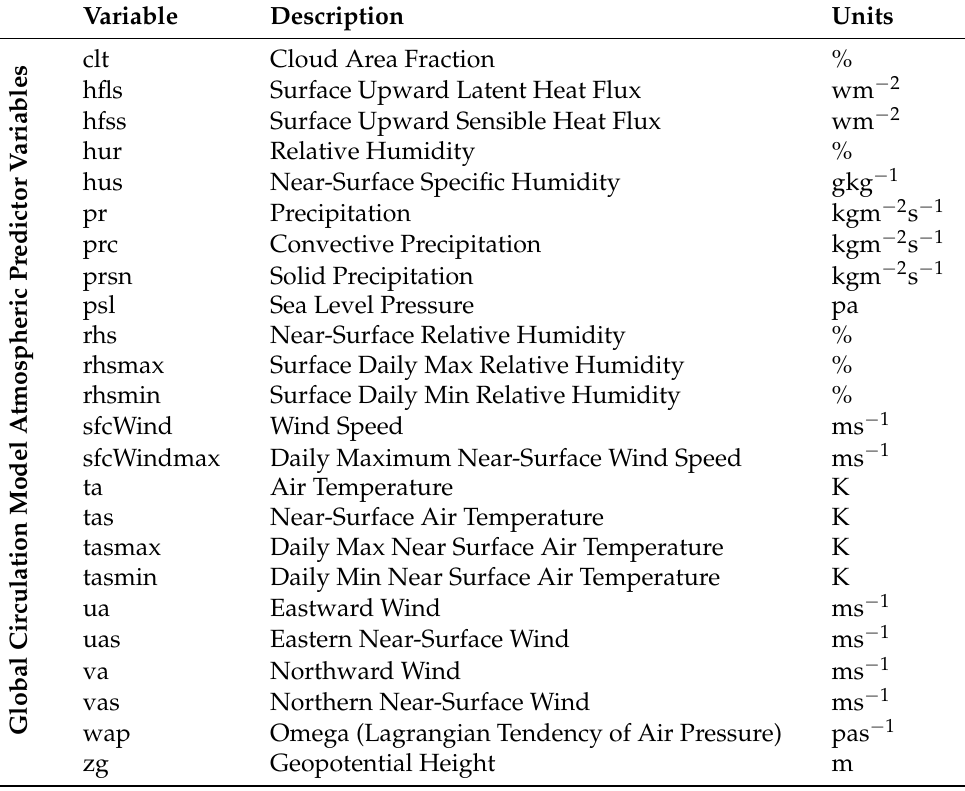
Table 2. Predictor variables for daily GSR. (a) Atmospheric variables from global climate models and (b) Ground-based observational climate data from Scientific Information for Landowners (SILO) used to train the proposed Deep Learning hybrid SAELSTM